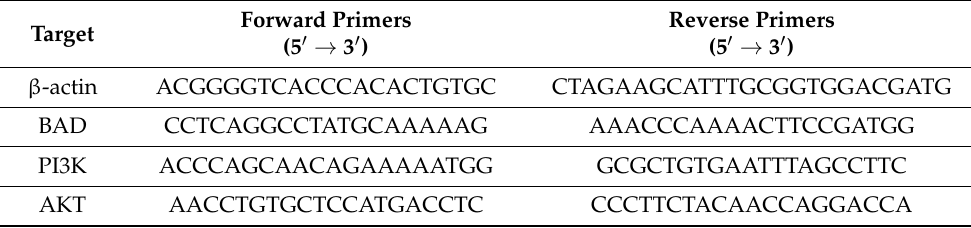
Table 4. Sequences of primers that were used to detect the expression of β -actin, BAD, PI3K, and AKT.